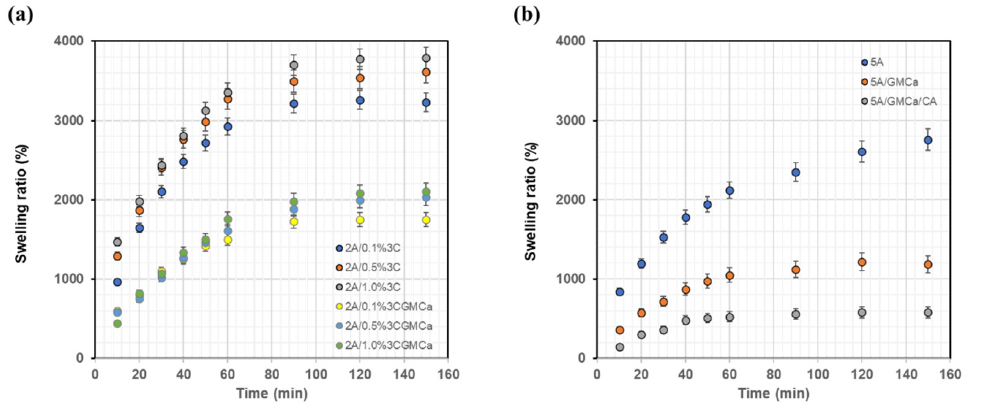
Figure 8. The swelling ratio of the beads as a function of immersion time in PBS solution: ( a ) alginate-chitosan (2A/x%3C, x = 0.1, 0.5, 1.0) and GM-loaded alginate-chitosan (2A/x%3CGMCa, x = 0.1, 0.5, 1.0) beads, and ( b ) alginate (5A), GM-loaded alginate (5A/GMCa), and GM-loaded alginate crosslinked with citric acid (5A/GMCa/CA) beads.